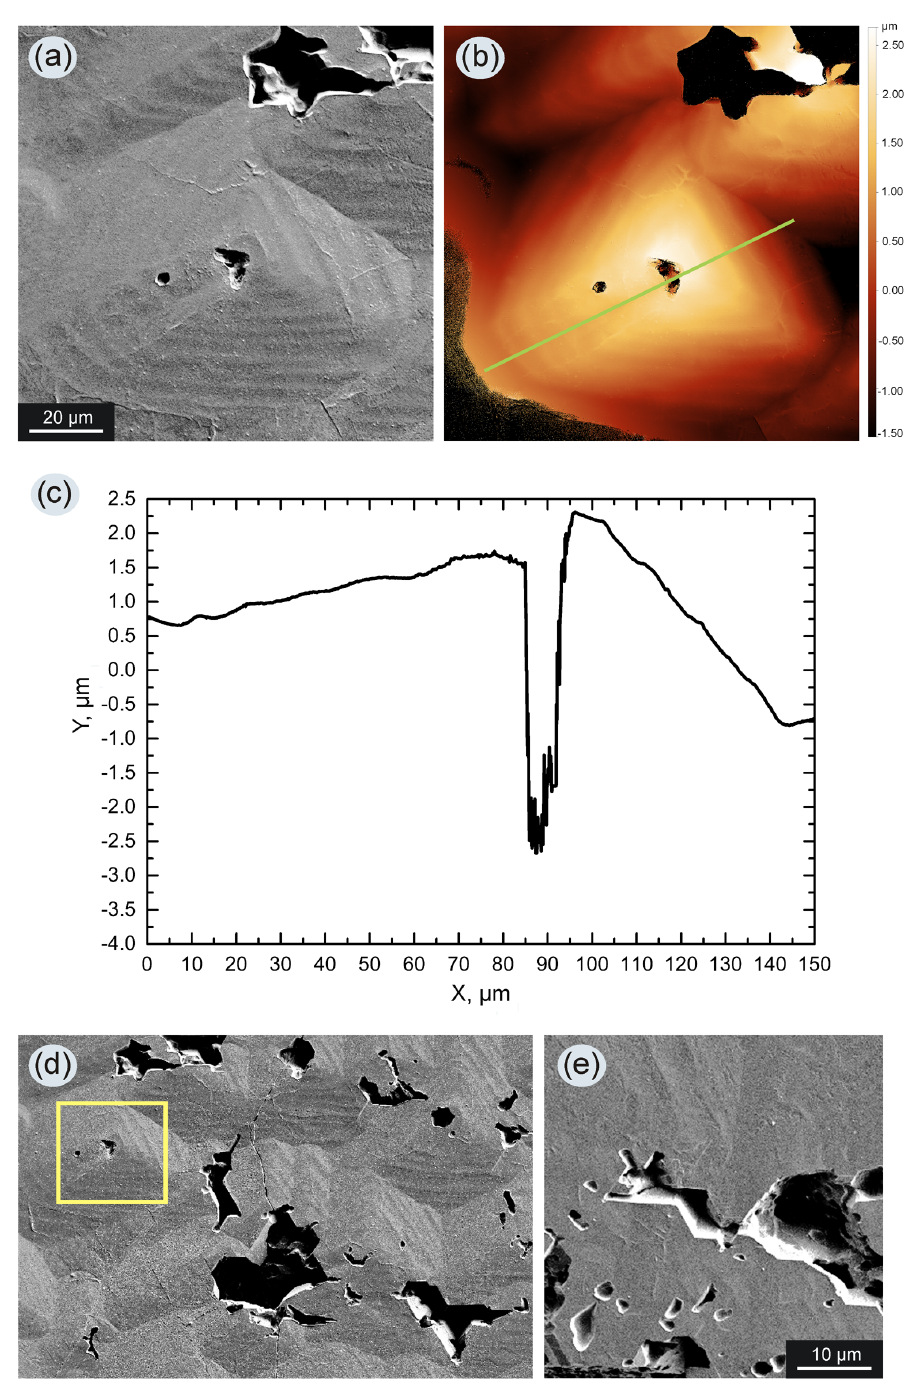
Figure 3. (a) SEM image of a growth pyramid on an octahedral face of diamond from run 2–51 with the addition of 5wt% silicates (assembly configuration shown in Fig. 1d) – a cavern is present in the top of the pyramid; (b) relief of the pyramid shown in (a) , measured by confocal laser scanning microscopy and the pyramid profile (c) ; (d) on (111) faces of the diamond, numerous pyramids are usually observed; the light-colored square indicates the pyramid that is shown in (a) ; (e) caverns on (111) diamond faces commonly have partially faceted